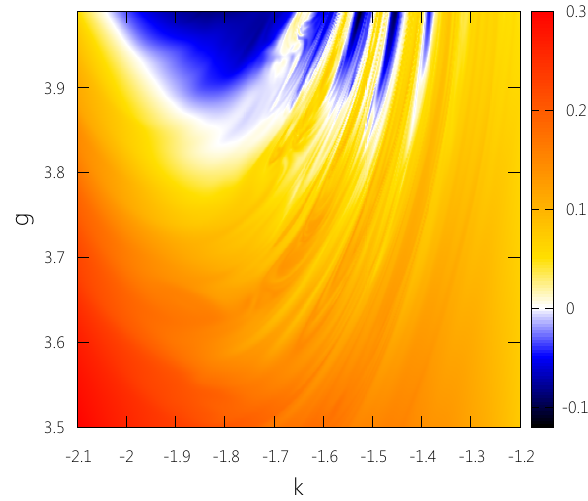
Fig. 5 Post-collision velocity of the kink as a function of the Yukawa coupling constant g and wave number k . The initial separation is x 0 = −